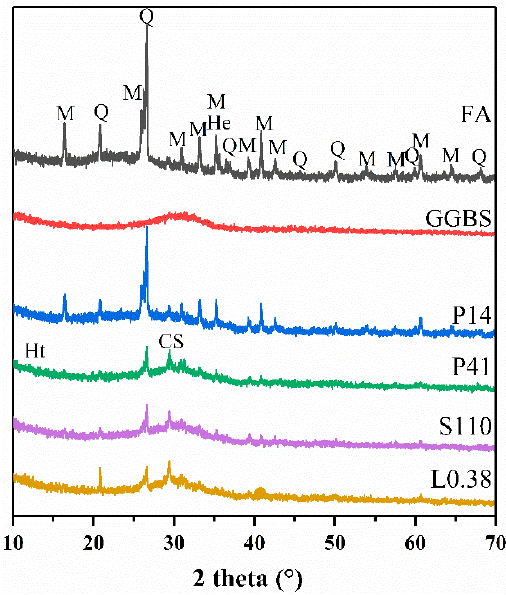
Figure 7. XRD patterns of precursors, group P14, P41, S110 and L0.38 at the age of 7 days. Legend: Q = quar tz ; M = mullite; He = hematite; Ht = hydrotalcite; CS = C-A-S-H.